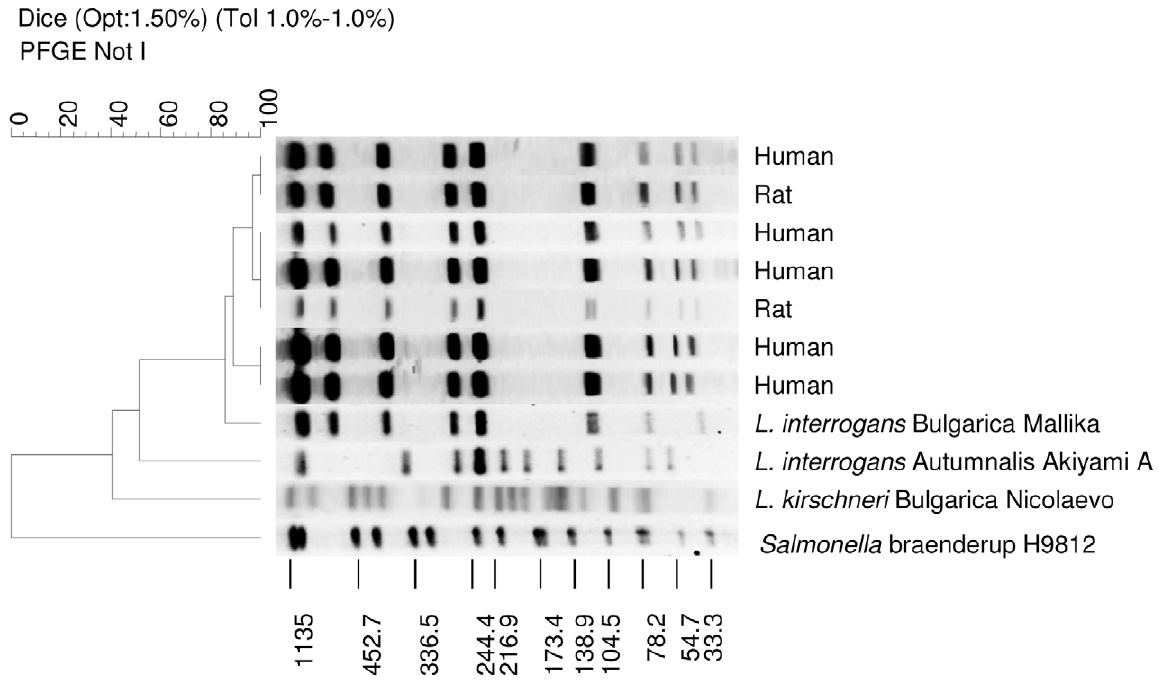
Figure 1. Selected PFGE patterns of isolates collected from humans and rats in Thailand along with two reference strains of serovar Bulgarica showing two different species and reference serovar Autumnalis. Salmonella Braenderup H9812 is shown as the size standard.